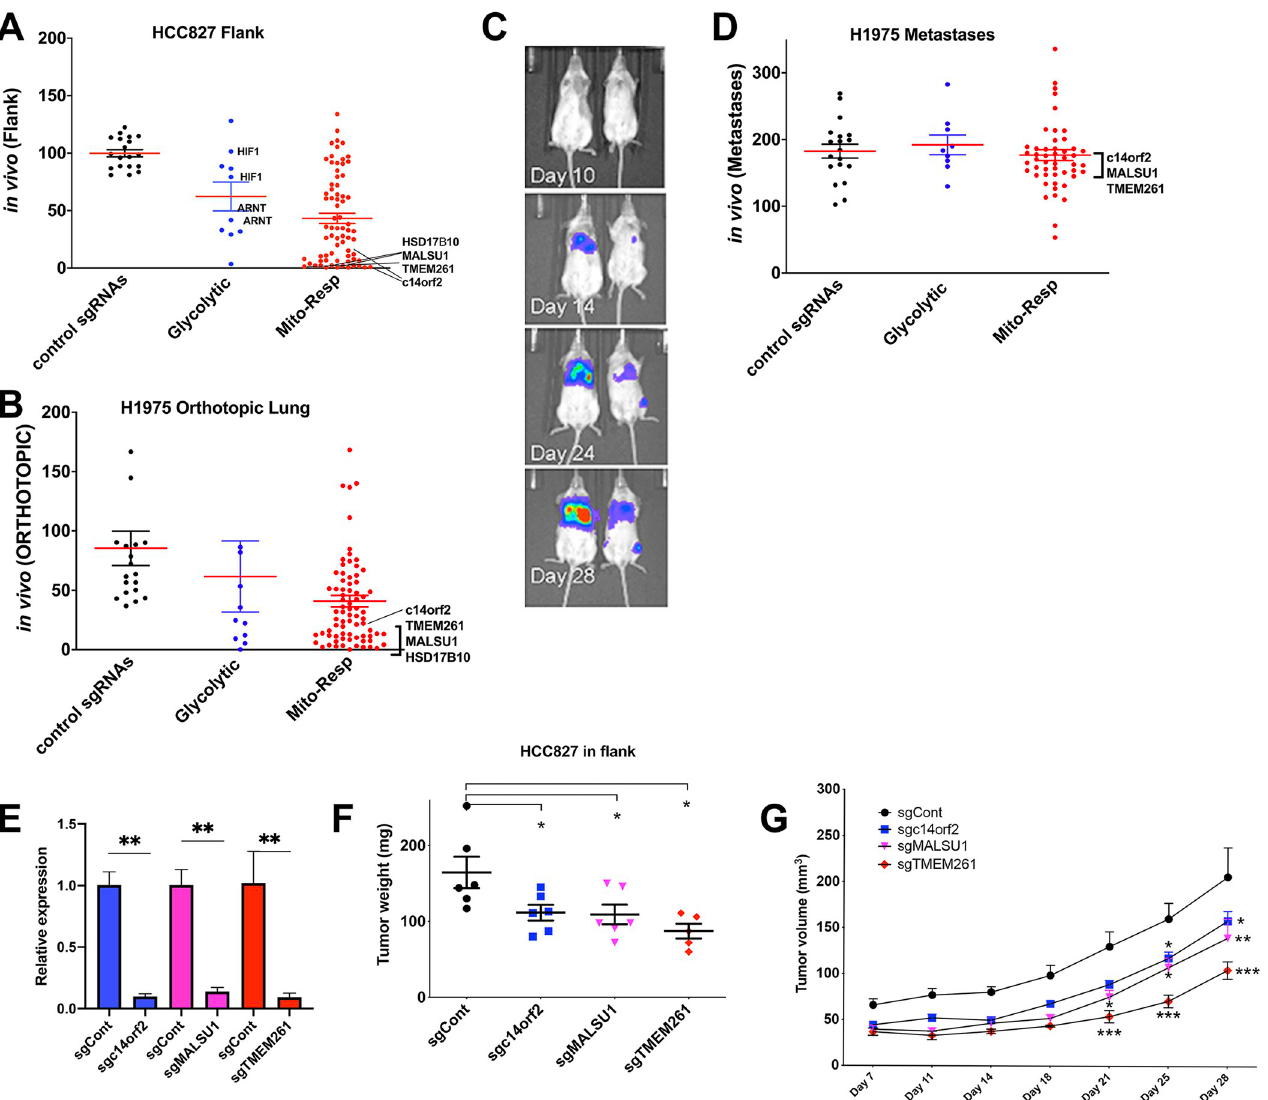
Fig 1. Human lung cancer cells demonstrate differential requirements for mitochondrial and respiratory genes when grown in vivo in flank or orthotopic lung models. HCC827 and H1975 human EGFR -mutant lung cancer cells were transduced with the mini-CRISPRi library and then injected into either the subcutaneous space in flanks (HCC827) or the left lower lung lobes (H1975) of nude mice and grown for 28 days. DNA from each tumor was sequenced and read counts for each sgRNA quantified. The read count for each sgRNA was normalized to the sum of reads for negative control sgRNAs and the ratio of each sgRNA’s frequency in the tumor model relative to its frequency in vitro (immediately preinjection). ( A) Read count frequency in the HCC827 cell model. Two independent replicate experiments were performed, with n = 6 for each experiment (for n = 12 total). Each dot represents a single sgRNA and indicates its average normalized representation (computed from 2 independent replicate experiments), organized and displayed as control sgRNAs and sgRNAs targeting ATP-modulating genes classified as glycolytic or mito-respiratory (termed Mito-Resp). Mito-Resp sgRNAs were among the most severely depleted in vivo ( HSD17 β 10 , TMEM261 , MALSU1 , c14orf2 ) (mean and SEM shown) (mean % representation of nontargeting, glycolytic and mito-respiratory sgRNAs as groups are 99.9%, 62.6%, and 42.2%, respectively. One-way ANOVA of all 3 groups of sgRNAs demonstrate p -value < 0.0001, with Tukey’s multiple comparisons test between glycolytic and control p < 0.02, mito-resp and control p < 0.0001, and between glycolytic and mito-resp ns). ( B) H1975 cells grown orthotopically in the lungs of nude mice ( n = 6) were dissected and analyzed using the same approach as for flank tumors (A) (mean % representation of nontargeting, glycolytic, and mito-respiratory sgRNAs are 85.4%, 61.6%, and 40.9%, respectively. One-way ANOVA of all 3 groups of sgRNAs demonstrate p -value = 0.006, with Tukey’s multiple comparisons test between glycolytic and control ns, mito-resp and control p -0.005, and between glycolytic and mito-resp ns). ( C) Bioluminescent imaging of tumor growth and metastasis in the H1975 model (2 representative mice shown), demonstrating tumor progression in the primary site and metastatic spread to mediastinum and contralateral lung by day 28. In addition, an extrathoracic distant metastasis (left femoral metastasis) developed (blue signal in the leg of the animal on the right). All metastases were confirmed at necropsy and analyzed by sequencing. ( D) Mean % representation of nontargeting, glycolytic, and mito-respiratory sgRNAs in H1975 metastases (7 individual metastases from 4 mice, normalized to the matched primary tumor) are plotted on the y-axis (mean and SEM shown, mean % representation of nontargeting, glycolytic, and mito-respiratory sgRNAs are 183%, 192%, and 177%, respectively, one-way ANOVA of all 3 groups of sgRNAs with Tukey’s multiple comparisons test demonstrate ns). (E-G) Validation of individual sgRNAs indicates that